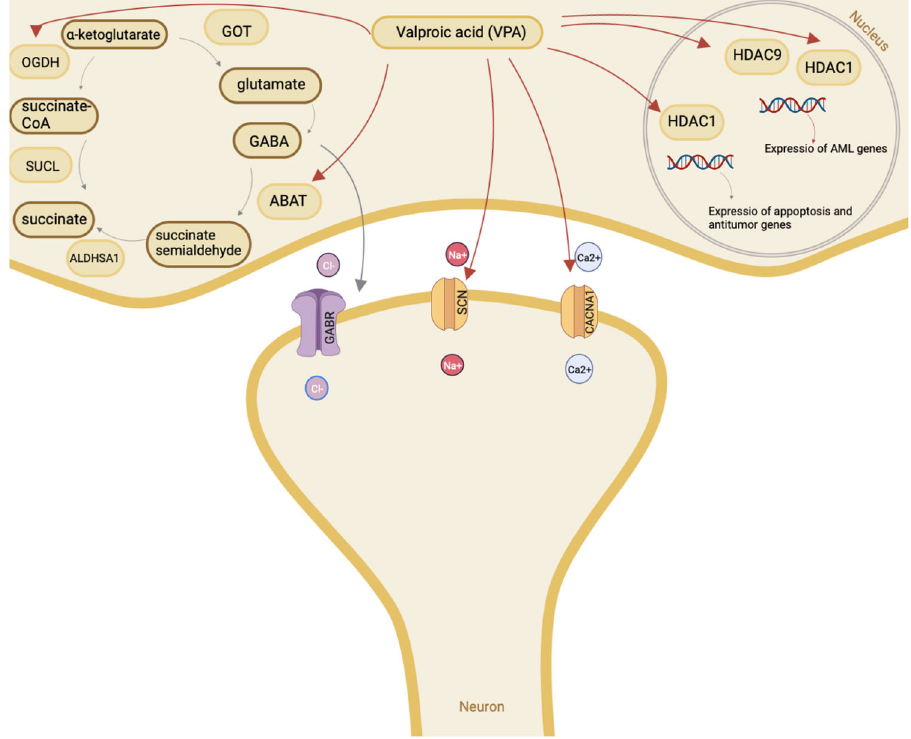
Figure 2. Mechanism of action of valproic acid. Note: GOT—glutamate ‐ oxaloacetate transaminase; GABA—gamma ‐ aminobutyric acid; ABAT—4 ‐ aminobutyrate aminotransferase; ALDHA1—aldehyde dehydrogenase; SUCL—succinate-CoA ligase; OGDH—oxoglutarate dehydrogenase; HDAC—histone deacetylase.